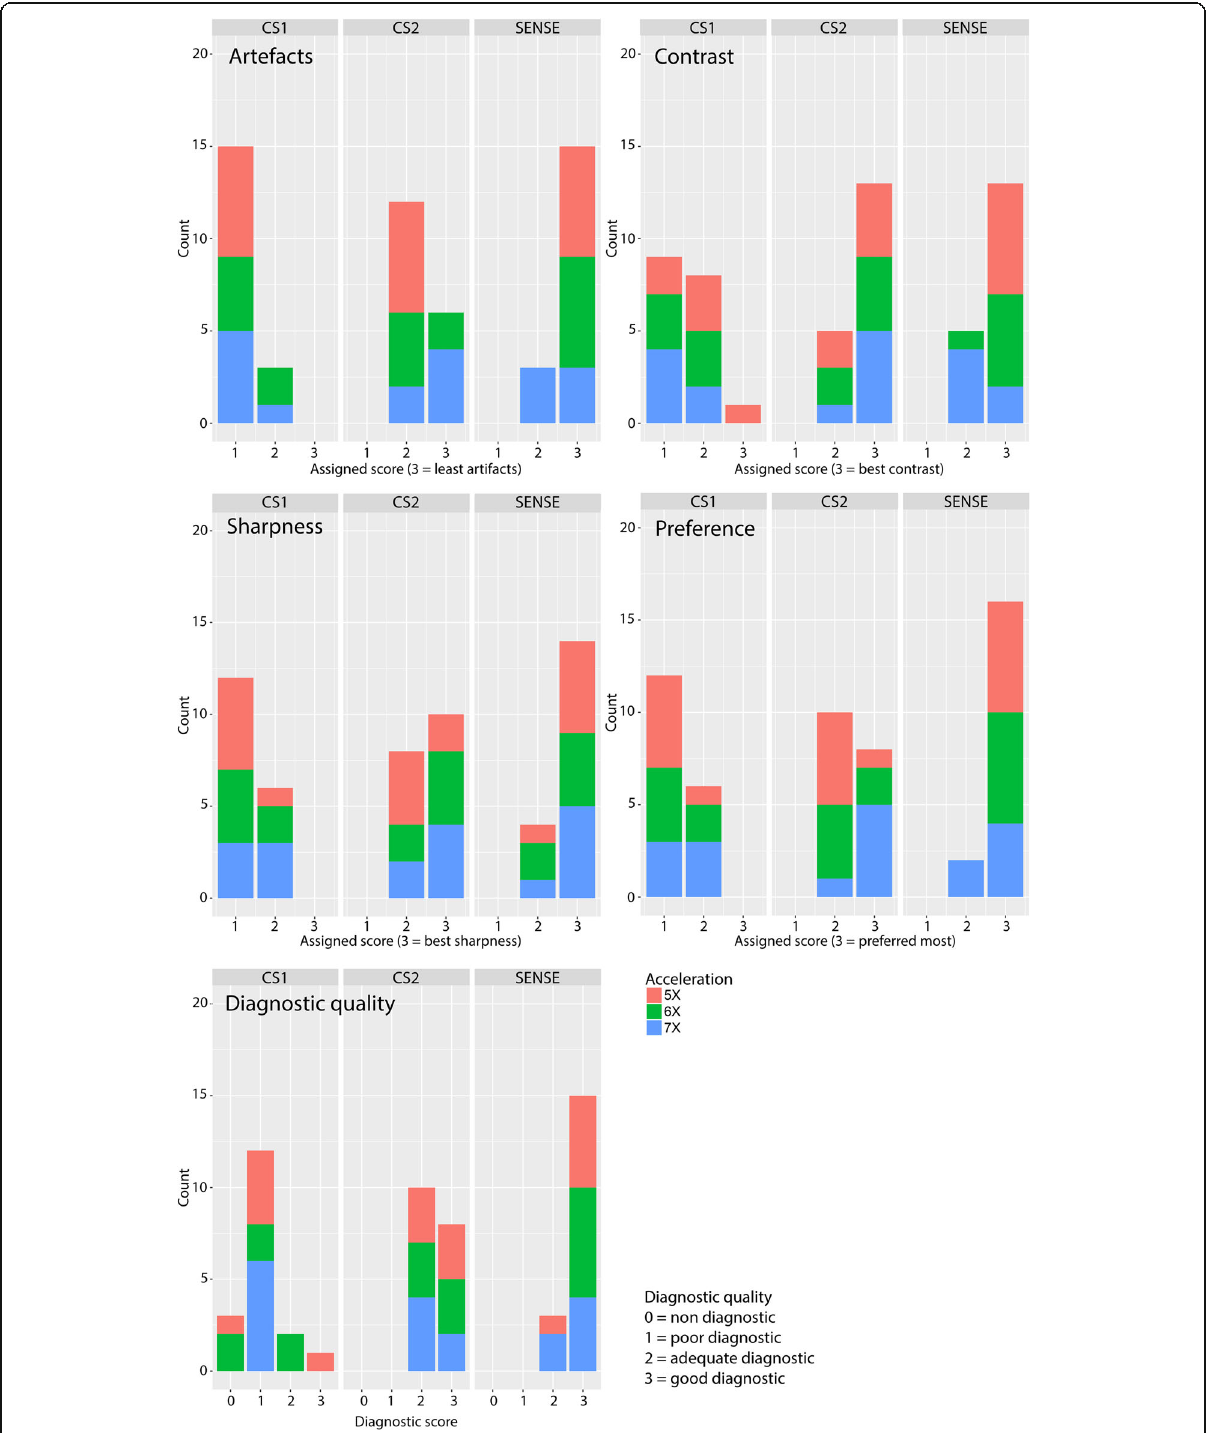
Fig. 8 Histograms of dynamic experiment representing the distribution of the accelerated datasets per scored value among the various scoring variables. CS1 , compressed sensing and parallel imaging (CS-PI) with equal sampling pattern. CS2 , CS-PI with varying sampling